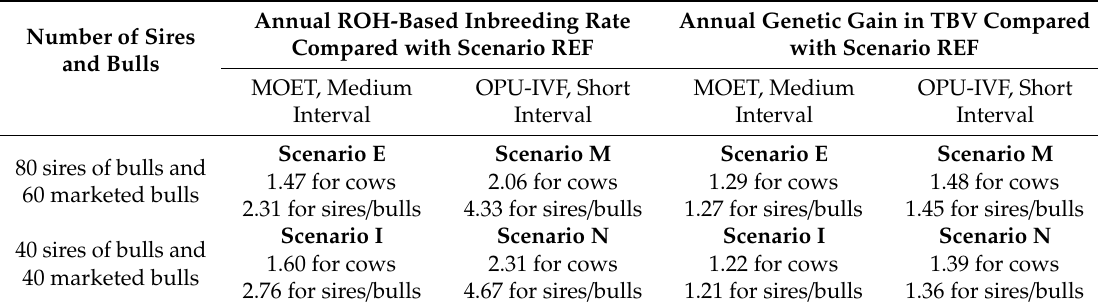
Table 4. Annual ROH-based inbreeding rate versus annual genetic gain among cows and sires / bulls for four di ff erent